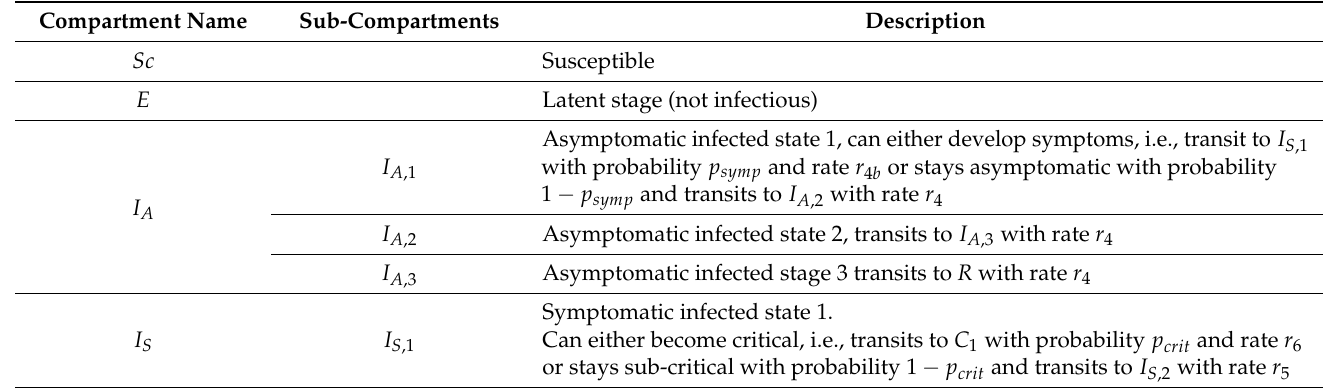
Table 1. Description of model compartments. We describe the compartments of the model and their biological meaning. Compartments E, I A , and I S are duplicated to account for two concurrent virus